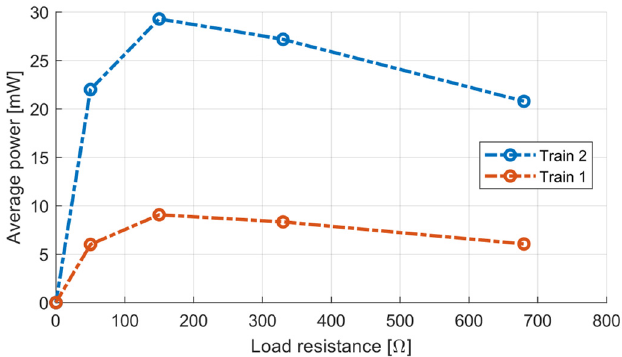
Figure 10. Average power depending on load resistance for Train 1 and Train 2.